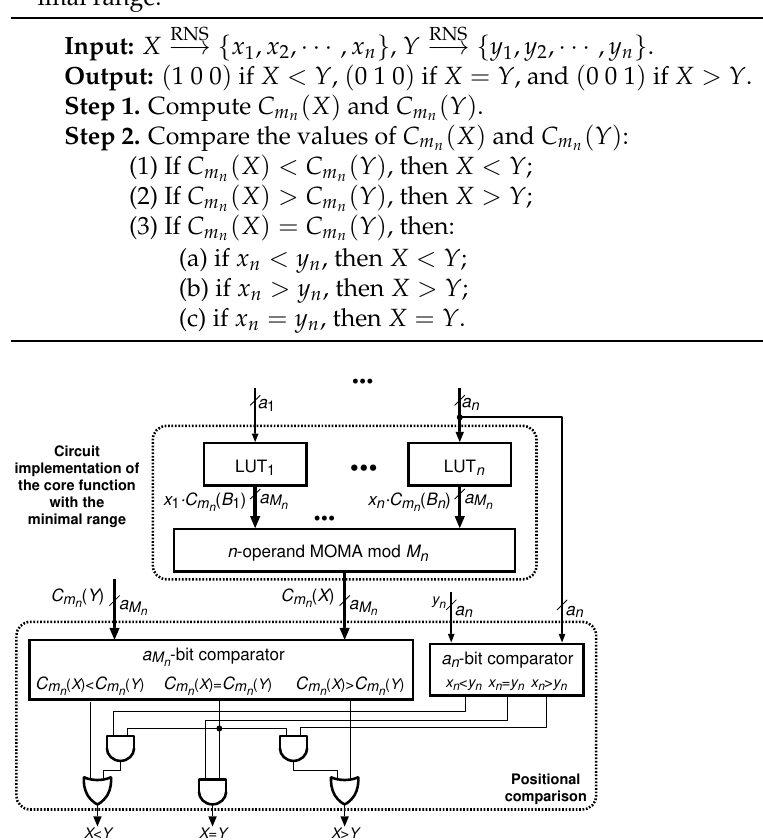
Algorithm 1: Comparison of RNS numbers using the core function with the min- imal range.